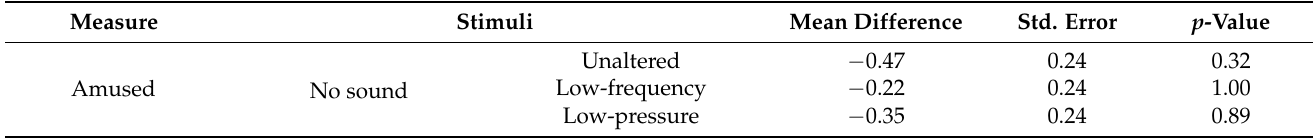
Table A5. Summary of the results of the pairwise comparisons of auditory conditions for emotion scores in Experiment